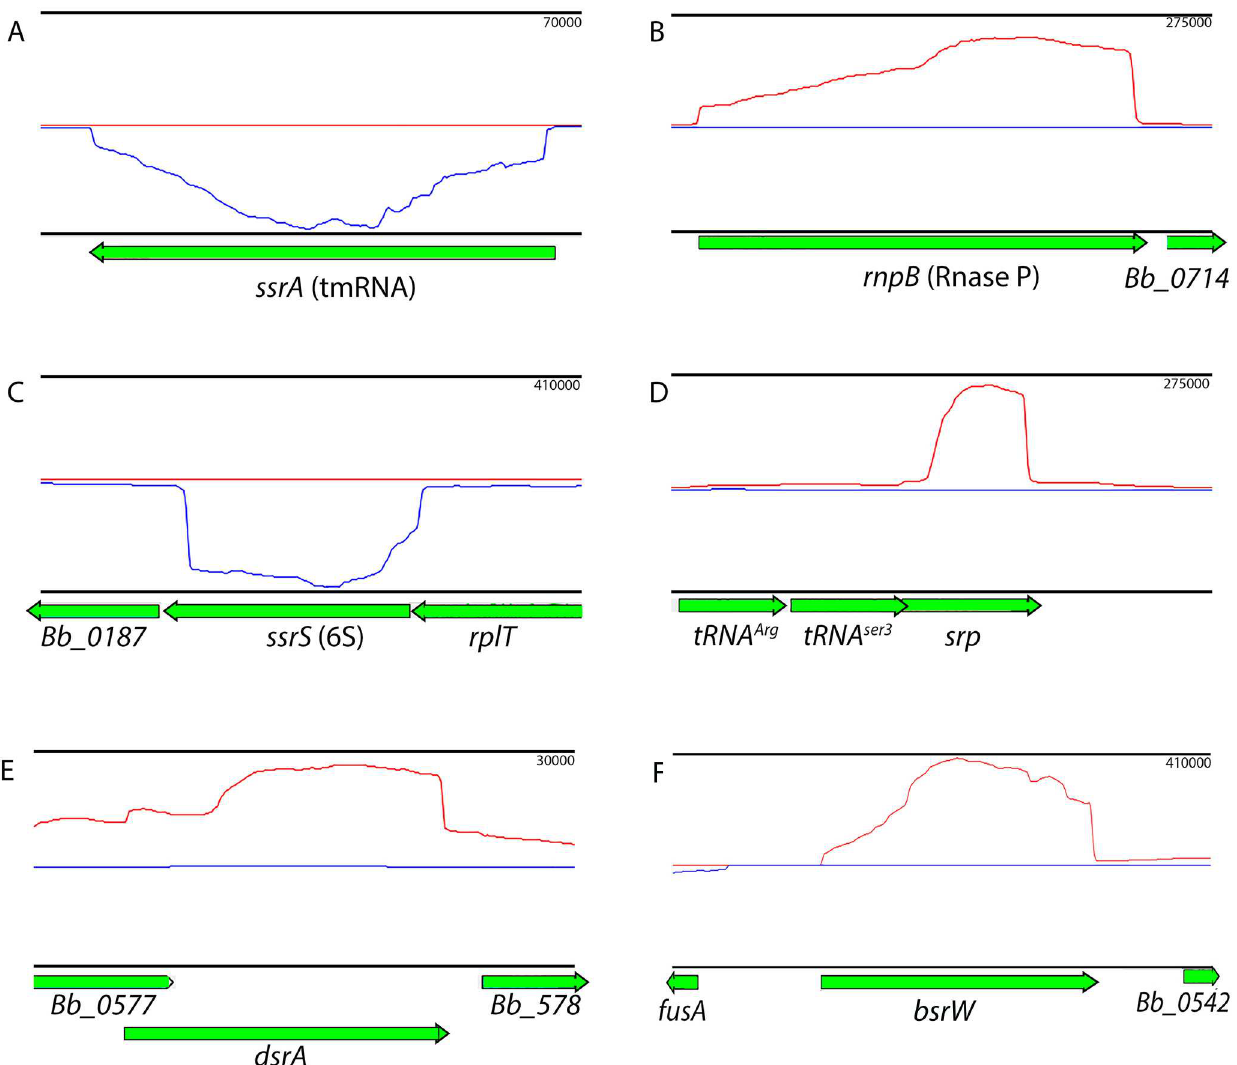
Fig 5. Examples of intergenic noncoding RNAs. Red lines indicate transcript abundancefrom the + strand (left to right) and blue indicate transcript abundance from the–strand(right to left), and are shown above (+) and below (-) the central axis. Genes are noted below coverage plots and directionality is given by arrows at the ends of genes. Relativeorientationof genes on the X axis is consistent with RefSeq annotations. Coverageper base is given on the Y axis to the left of the plot. Neither dsrA (E) nor 6S (C) are currently annotatedin either GenBank or RFAM. dsrA is shown as the longest possibletranscript describedin